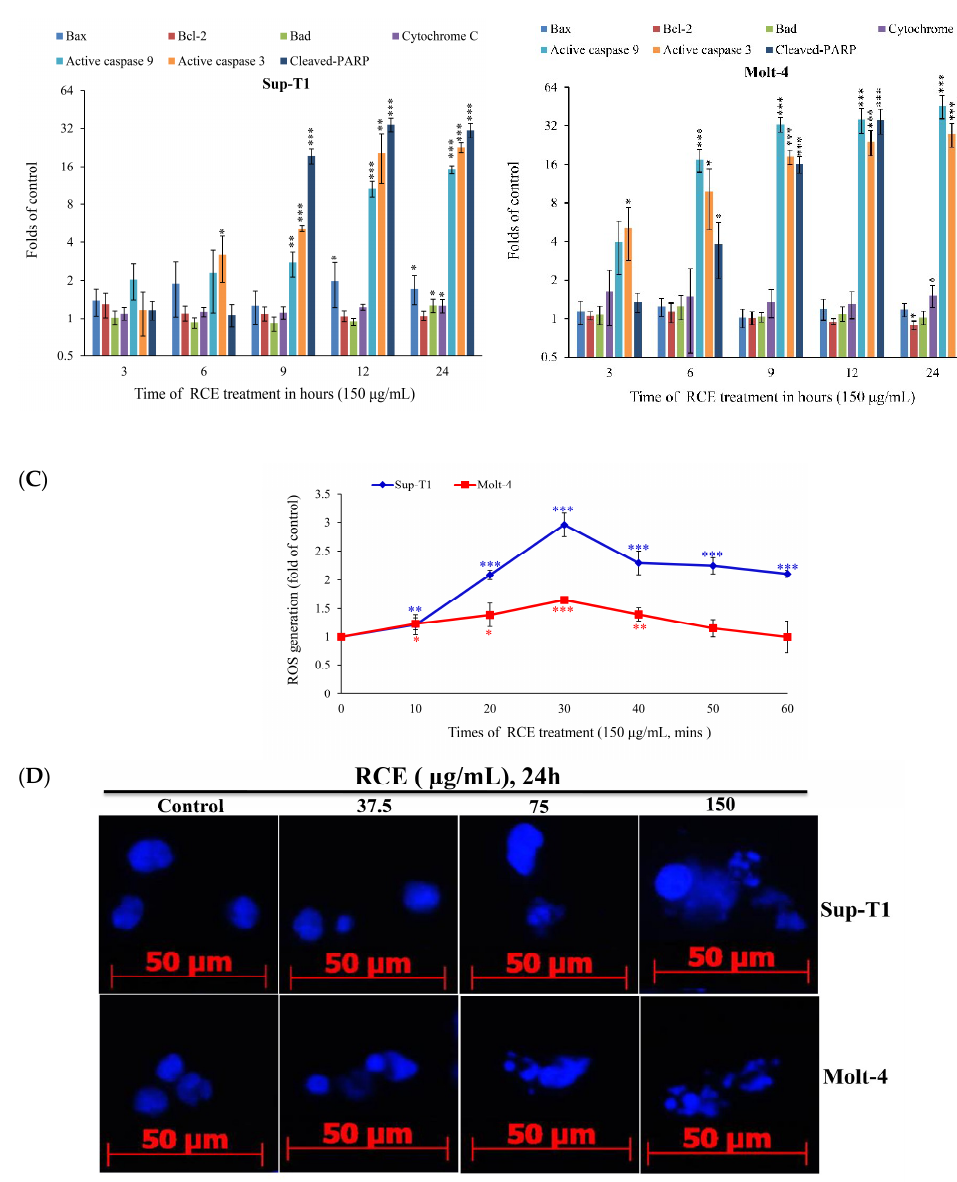
Figure 3. RCE treatment induces mitochondrial membrane potential (MMP) disruption and redox oxygen species (ROS) production in Sup-T1 and Molt-4 cells. Cells were treated with the indicated concentrations of RCE for 24 h; ( A ) Mitochondrial membrane potential of Sup-T1 and Molt-4 cells were assessed with JC-1 staining using flow cytometric analysis; ( B ) The effect of RCE on the expressions of mitochondria-related proteins of Sup-T1 and Molt-4 cells was examined with Western blotting assay. Actin was used as the loading control. The target protein was compared with the respective actin and then compared with the control group. The blots were quantified using the Odyssey image analysis system with National Institutes of Health ImageJ software. Cells were treated with RCE (150 µg/mL) for 3, 6, 9, 12, and 24 h; ( C ) Cells were treated with RCE (150 µg/mL) for the indicated times. Quantitative results showed a gradual increase in ROS production in response to RCE treatment when compared with the control group. The results are presented as mean ± SD of three independent experiments (* p < 0.05; ** p < 0.01; *** p < 0.001); ( D ) The changes of the nuclear morphology were determined with DAPI staining and observed in Sup-T1 and Molt-4 cells using a fluorescent microscope (400 × ). All results are expressed as the mean ± standard deviation of three independent experiments. p -values of statistical significance are represented as * p < 0.05, ** p < 0.01, and *** p <